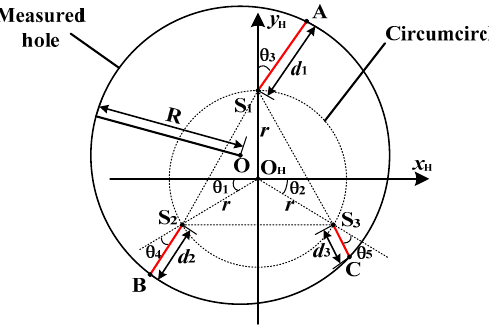
Figure 3. The measurement model of the inner diameter.